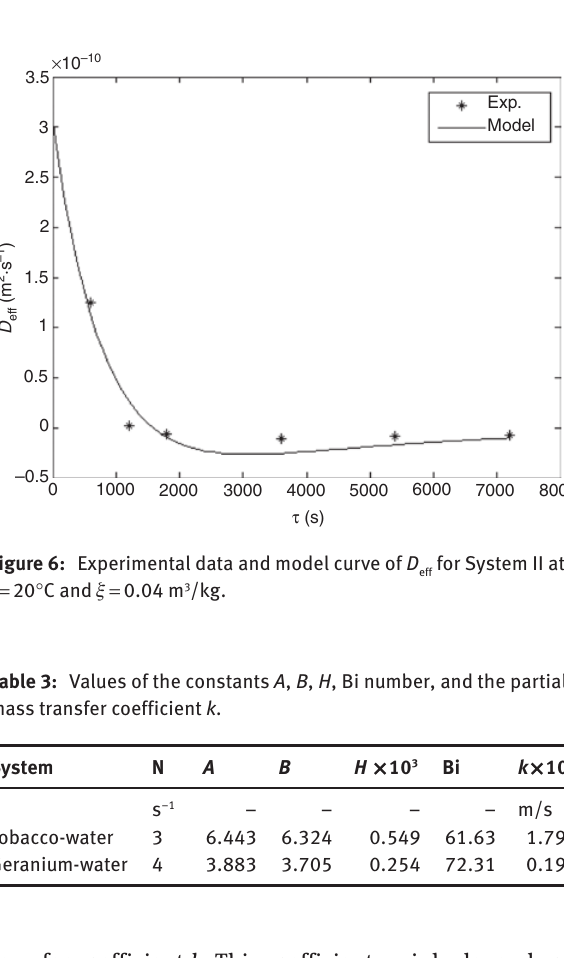
for System I at eff